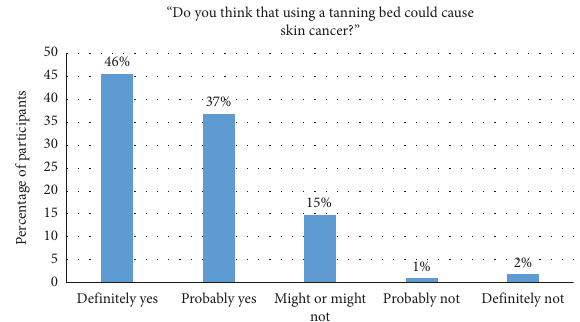
Figure 2: Tanning bed users’ perspectives on skin cancer.